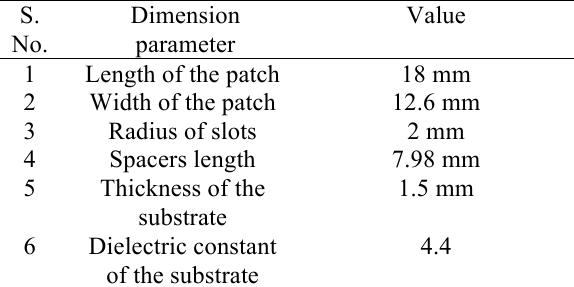
Table 1: Optimized dimensions.